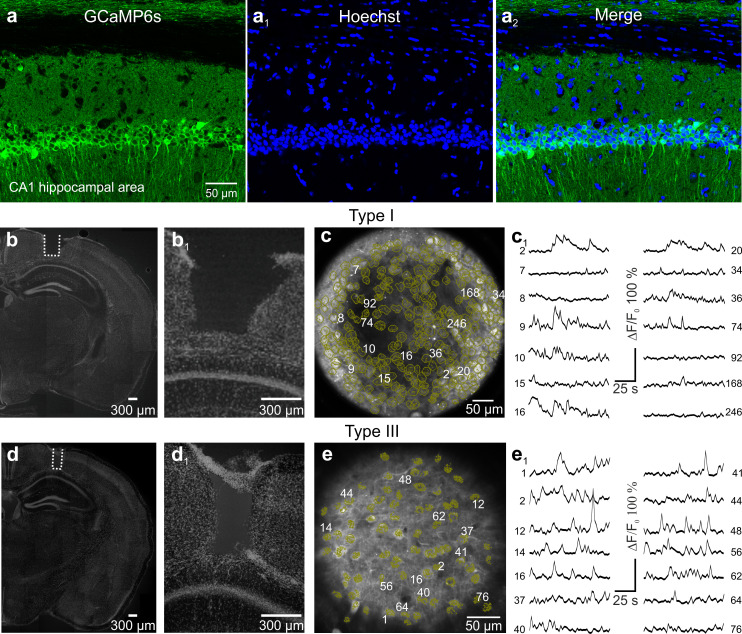
Hippocampal imaging with type I and type III eFOV-microendoscopes.(a-a2), Confocal images of hippocampal CA1 neurons expressing GCaMP6s (a). Nuclei were counterstained with Hoechst (a1). Images are merged in (a2). Scale bar in (a) applies to a1-a2. (b-b1) Confocal images showing coronal slices from a mouse implanted with type I eFOV-microendoscopes. Slices were counterstained with Hoechst. The probe track is highlighted with the white dotted line in (b) and shown at a higher magnification in b1. (c-c1) GCaMP6s expressing CA1 hippocampal neurons recorded by two-photon imaging using type I eFOV-microendoscopes in an anesthetized mouse. ROIs are indicated by yellow lines. Examples of fluorescence change over time are shown in c1. (d-d1) Same as in (b–b1) but for type III eFOV-microendoscopes. (e–e1) Same as in (c–c1) but for type III eFOV-microendoscope.